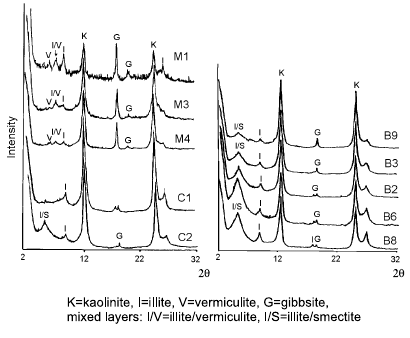
Fig. 2 – Ethylene glicol X-ray patterns in bottom sediments of Macacu and Caceribu rivers and Guanabara Bay. K = kaolinite, I = illite, V = vermiculite, G = gibbsite; mixed layers: I/V = illite/vermiculite, I/S = illite/smectite.